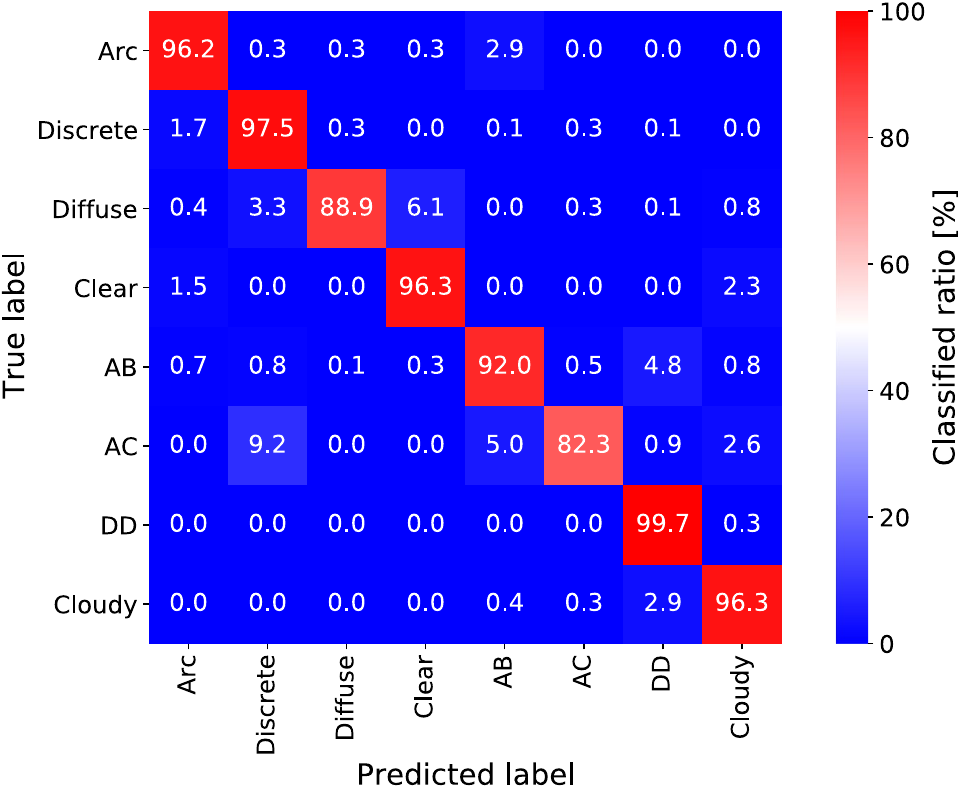
Figure 2. The classification result of the validation dataset by the trained ResNet-50 model. The top row shows that 96.2% of the 315 manually classified Arc images were correctly classified as Arc , while 2.9% were incorrectly classified as Aurora but bright . All the panels with matching true and predicted labels have high values of classified ratio, indicating high classifier